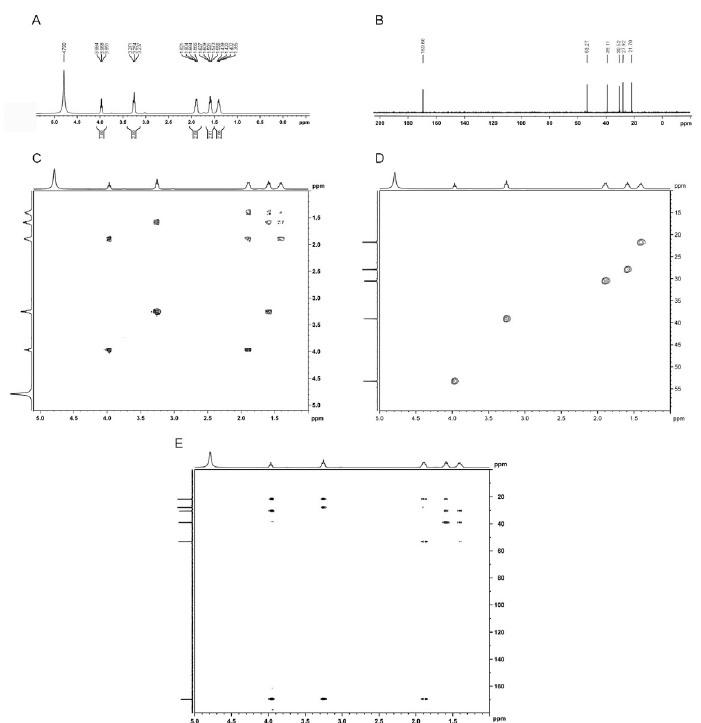
Figure 4. ( A ) 1 H-NMR spectrum of the pure active compound produced by Streptomyces STZ; ( B ) 13 C-NMR spectrum of the pure active compound produced by Streptomyces STZ; ( C ) H-HCOSY spectrum of the pure active compound produced by Streptomyces STZ; ( D ) HSQC spectrum of the pure active compound produced by Streptomyces STZ; ( E ) HMBC spectrum of the pure active compound produced by Streptomyces STZ.